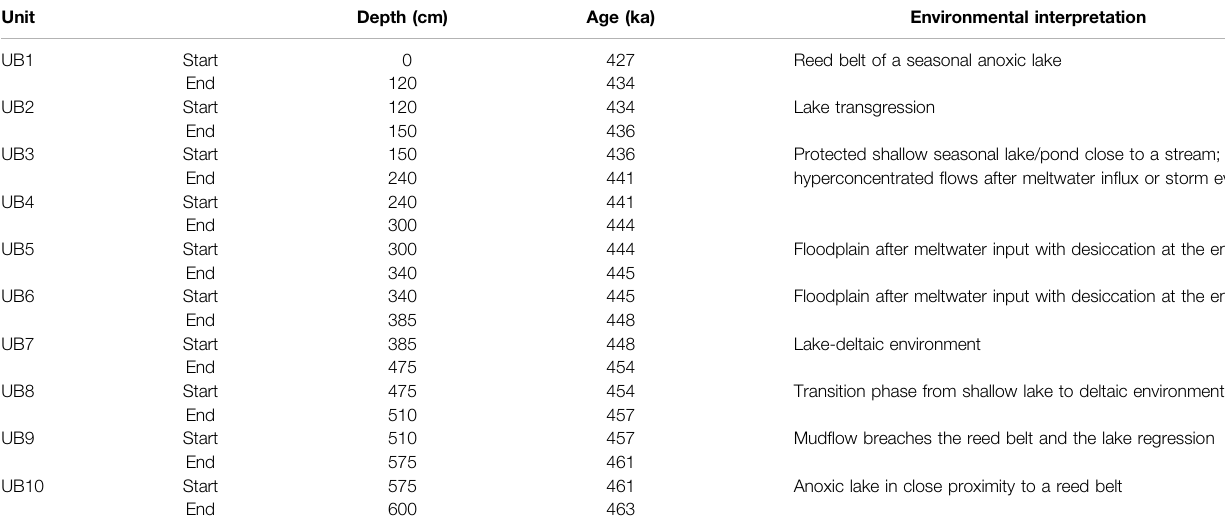
TABLE 7 | Lake-level reconstruction of